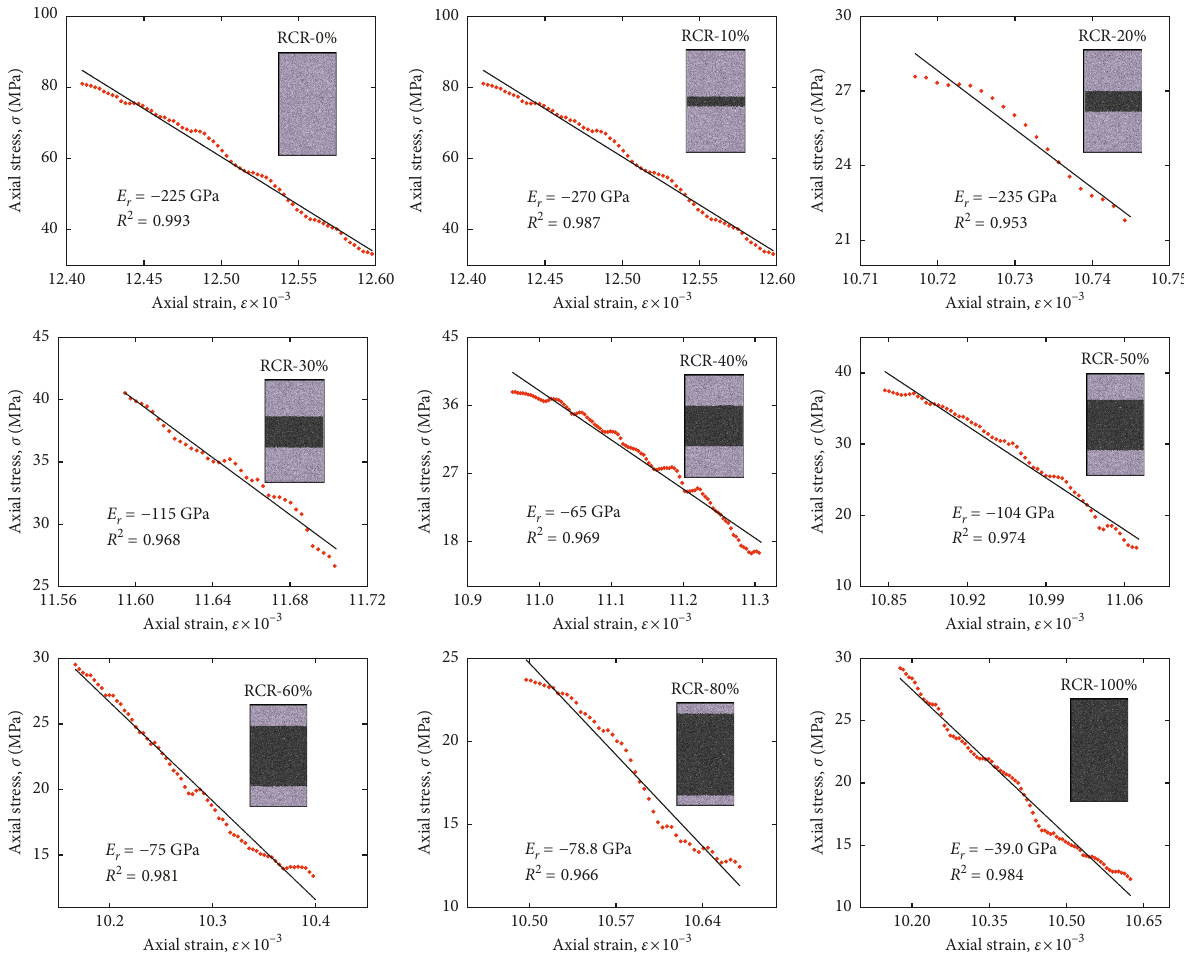
Figure 11: Postpeak stages and linear fitted curves.